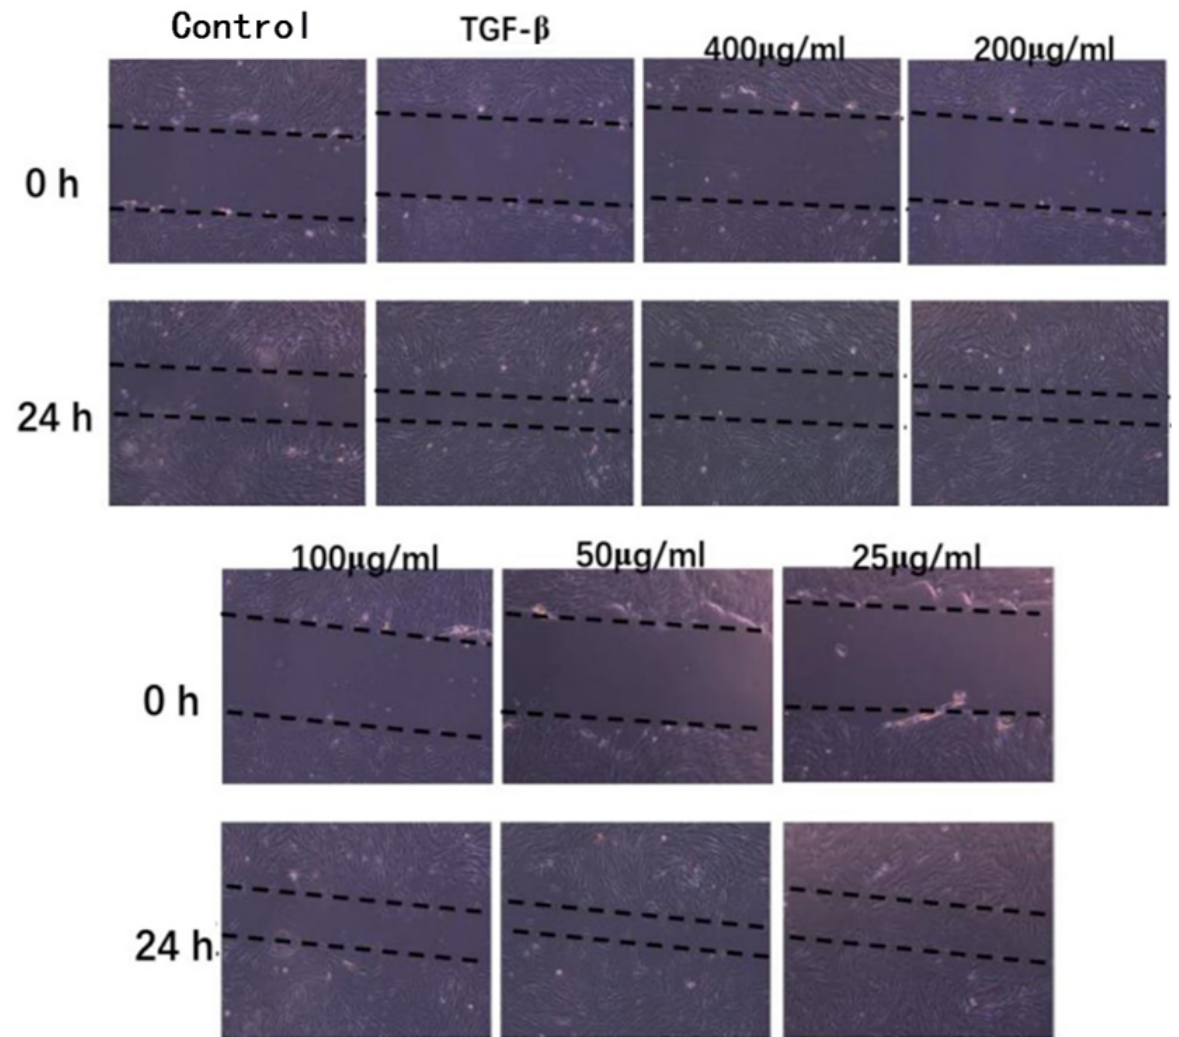
Figure 6. Images of healing condition of HDF scratches after 24 h. Table 6. Healing rate of HDF scratches (* p < 0.05, ** p < 0.01).